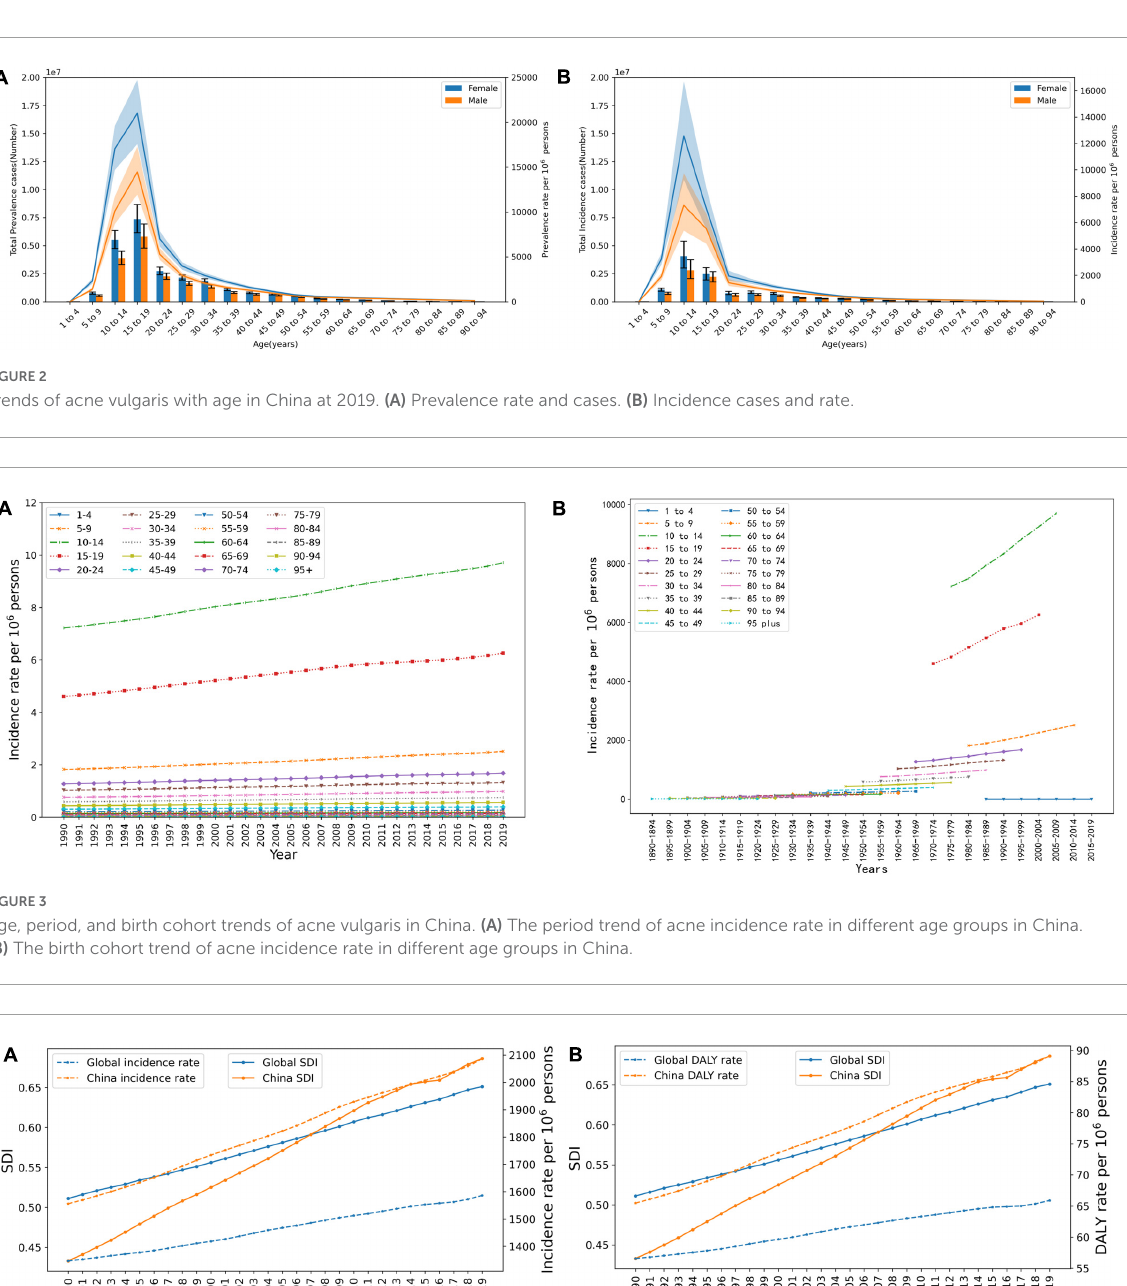
and according to the GBD, in 2019 the age-standardized prevalence and incidence levels of acne vulgaris in China were much higher than in most Asian countries, and third in Asia after Korea and Japan, with data showing a positive correlation between acne burden and national wealth, suggesting that acne prevalence is lower in rural,